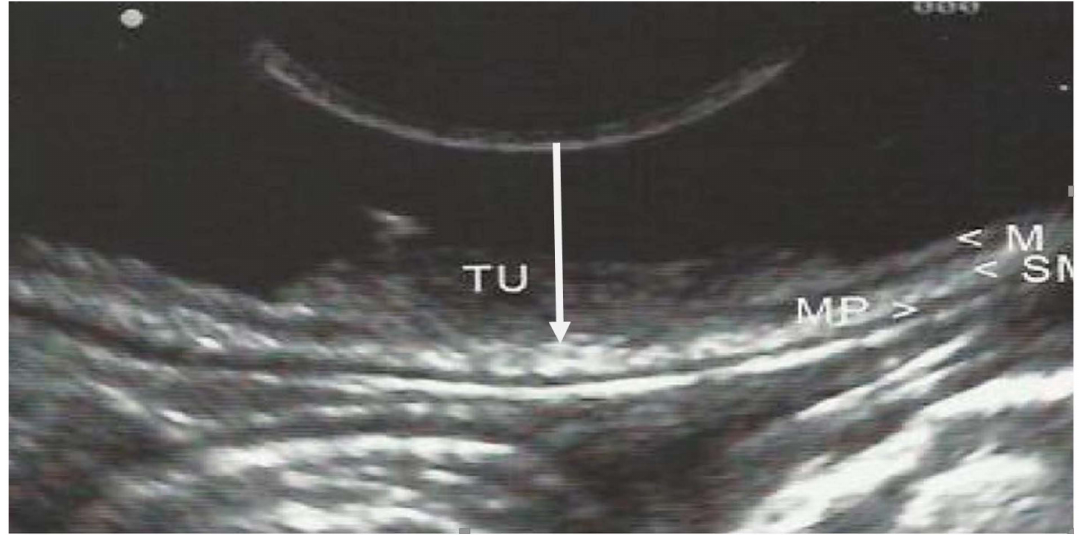
Figure 3. EUS of early gastric cancer (arrow) limited to the lamina propria. Staging uT1m1. (LU—lumen; M—mucosa; SM—submucosa; MP— muscularis propria ). B—balloon.